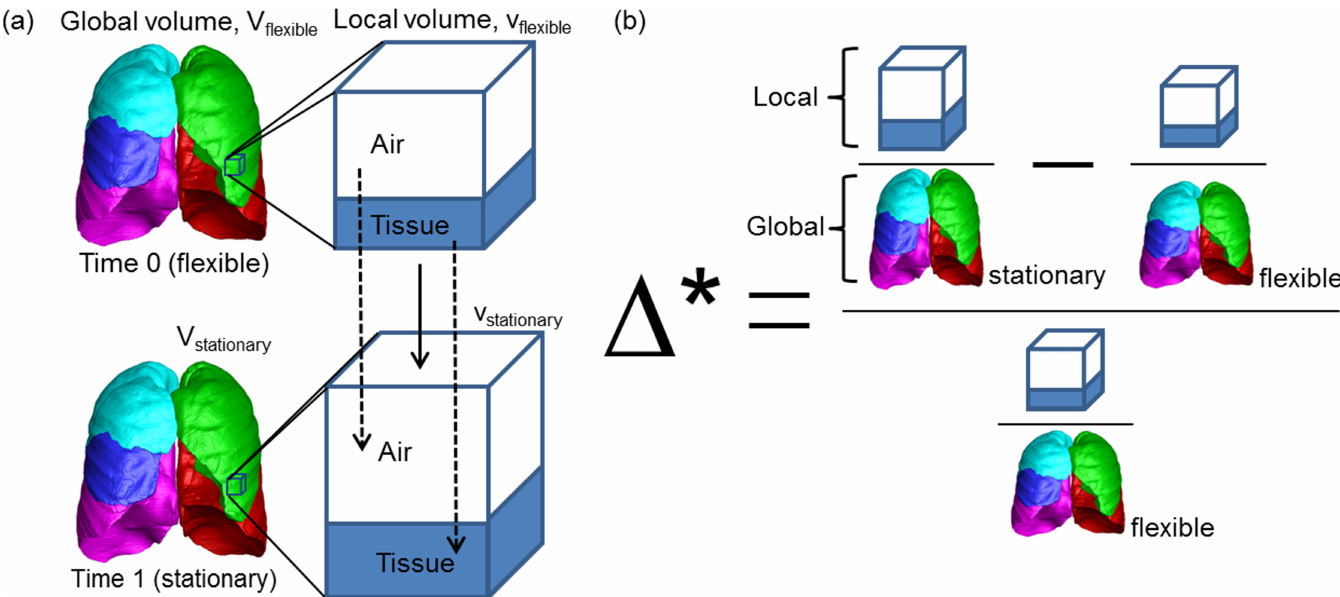
Fig 2. Schematicof (a) globaland local lung volume changesand (b) formulation of normalized fractional volume change.